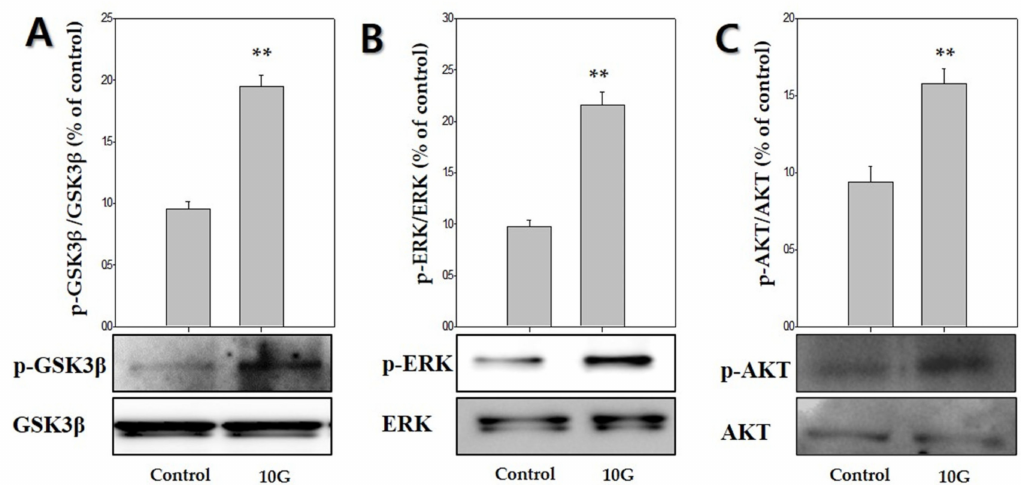
Figure 5. Extremely low-frequency electromagnetic fields (ELF-EMFs) stimulate anagen-related molecules by regulating the GSK3 β / ERK / AKT signaling pathway. Protein levels were determined via Western blot analysis. ( A ) p-GSK3 β expression; ( B ) p-ERK expression; ( C ) p-AKT expression. Each bar represents mean ± standard error of independent experiments performed in triplicate ( n =